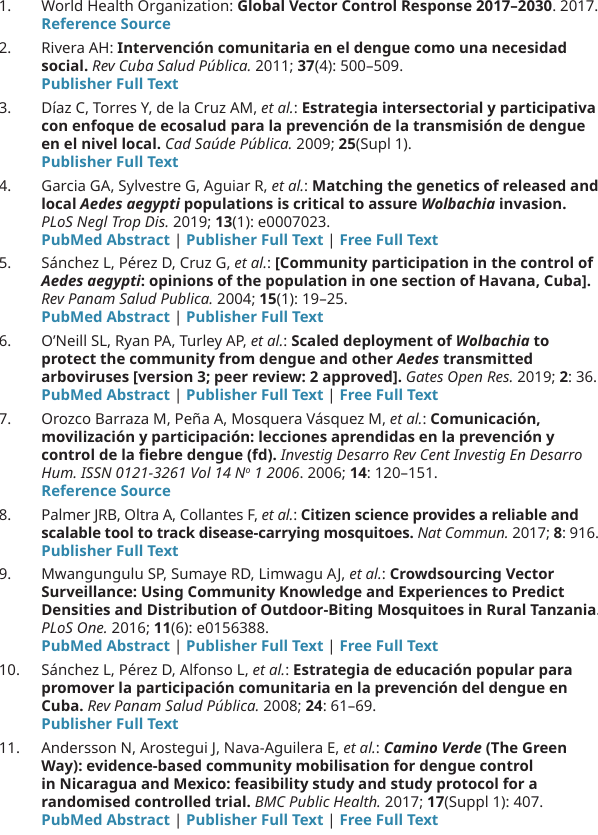
12. Costa GB: Participation et dialogue dans la gestion environnementale au Brésil : le cas du Monument Naturel des Monts du Pain de Sucre et